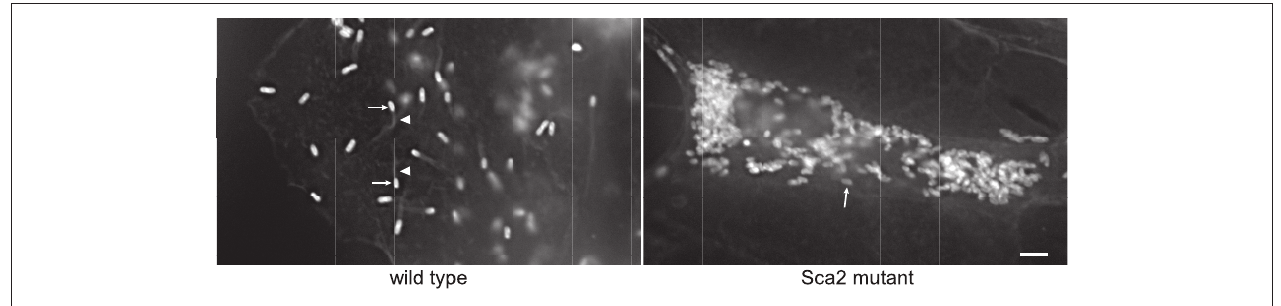
Figure 1 | A Himar1 insertion in R. rickettsii sca2 eliminates actin-based motility. The right micrograph shows wild-type R. rickettsii (arrows) with typical filamentous actin tails (arrowhead). The left micrograph depicts a small plaque- forming mutant of R. rickettsii with a Himar1 insertion in sca2, which encodes an